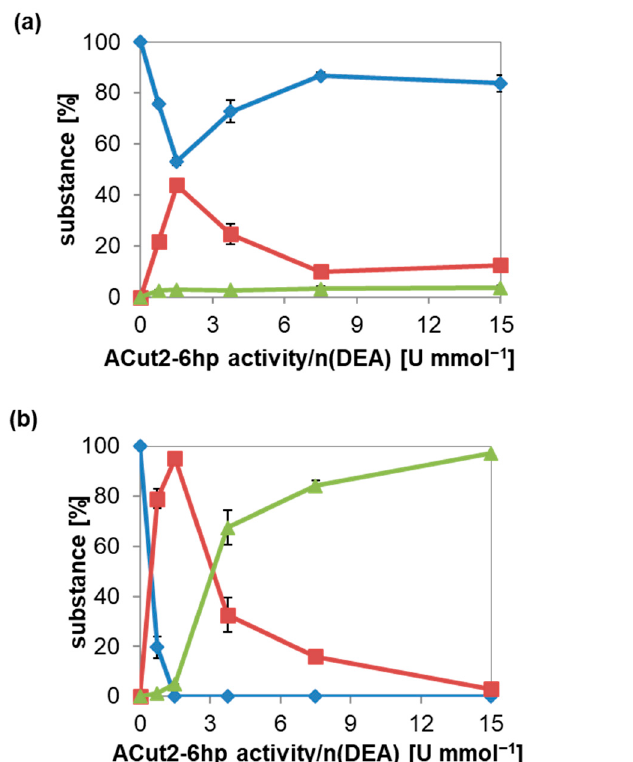
Figure 3. DEA hydrolysis catalyzed by ACut2-6hp depending on the enzyme concentration. Hydrol- ysis was done in a volume of 200 µ L with 50 mM DEA in 100 mM sodium phosphate pH 7.5 with different enzyme concentrations for 2 ( a ) or 16 h ( b ) by ACut2-6hp containing culture supernatant. An ACut2-6hp activity/n(DEA) of 2.5 U mmol − 1 corresponds to 5 µ L Acut2-6hp culture supernatant, or 0.02 U, or 0.57 µ g protein. Measurements were made in duplicate. Represented are the mean ± SD. Although the DEA hydrolysis was fastest with 1.5 U mmol − 1 ACut2-6hp, only minimal AA was found after 16 h (Figure 3b); up to 95% MEA and only 4.9% AA were synthesized. Higher enzyme activities promoted the synthesis of the unwanted diacid AA, which was formed up to 97% in 16 h when 15 U mmol − 1 cutinase activity was